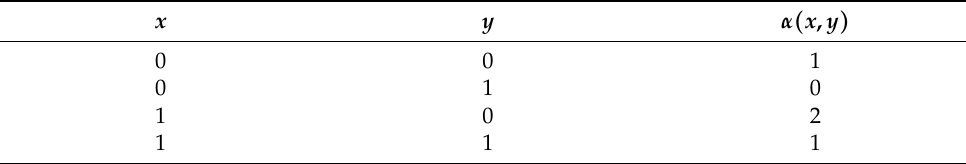
Table 1. The binary α operation. x y